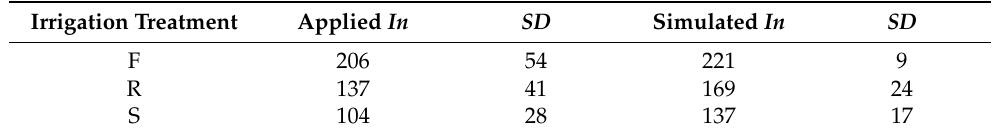
Table 7. Average applied and simulated irrigation norms In (mm) per irrigation treatment; full (F) and deficit (R and S) irrigation, including standard deviation.